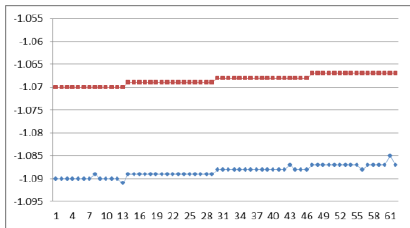
Figure 2. The angle between solar orientation vector and the X axis of the sensor coordinate system during a period of